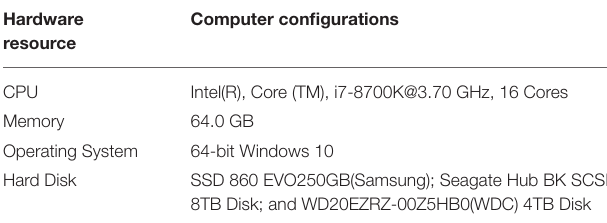
TABLE 1 | Computer hardware resource in this paper. Hardware Computer configurations resource